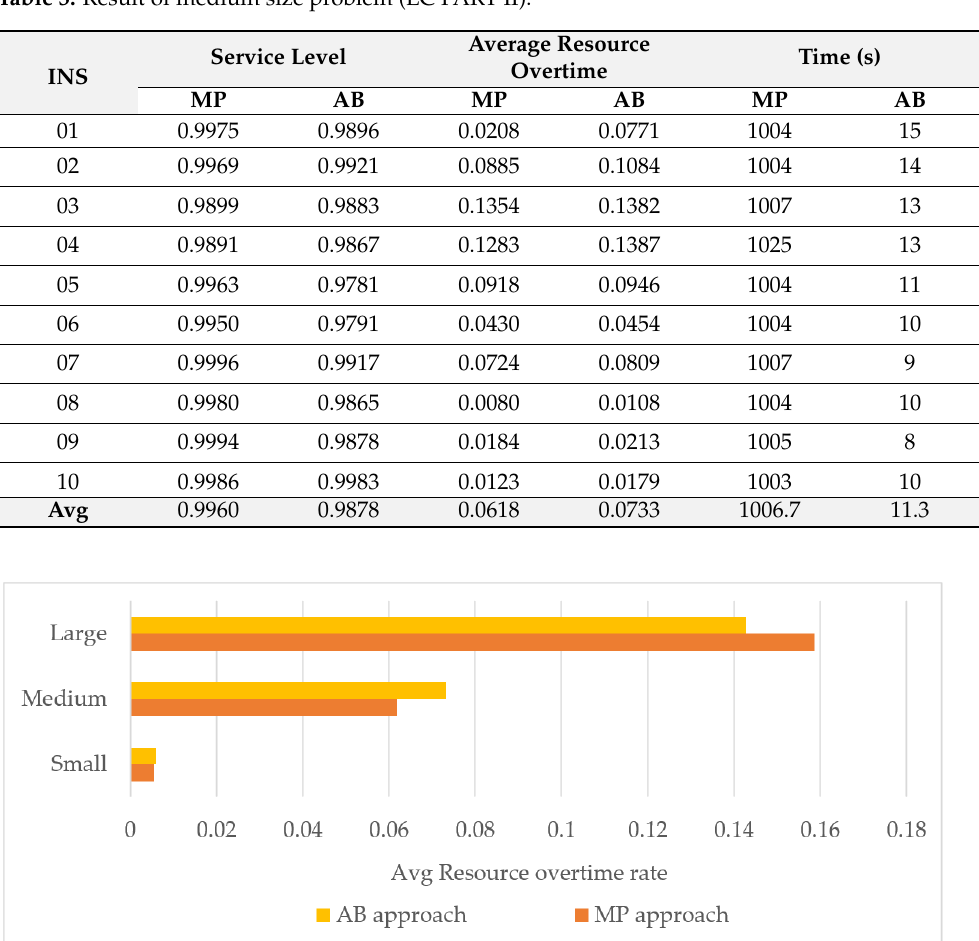
Table 3. Result of medium size problem (EC PART II).